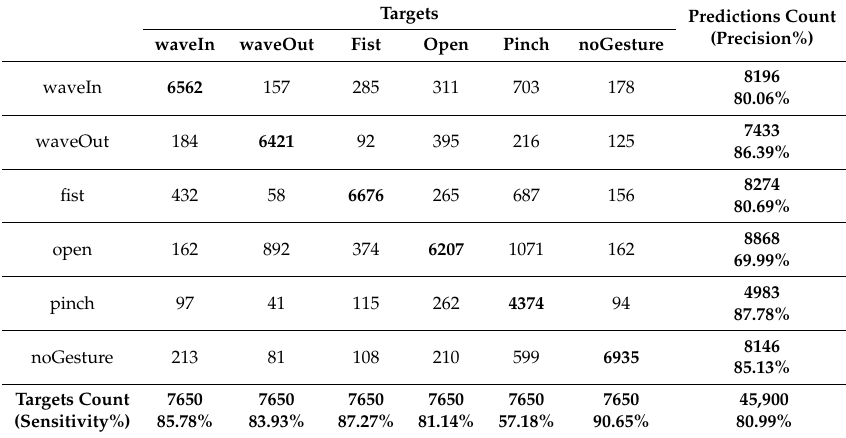
Table A18. Confusion matrix for experiment 4 . Synchronization gestures ( sync = 3 )